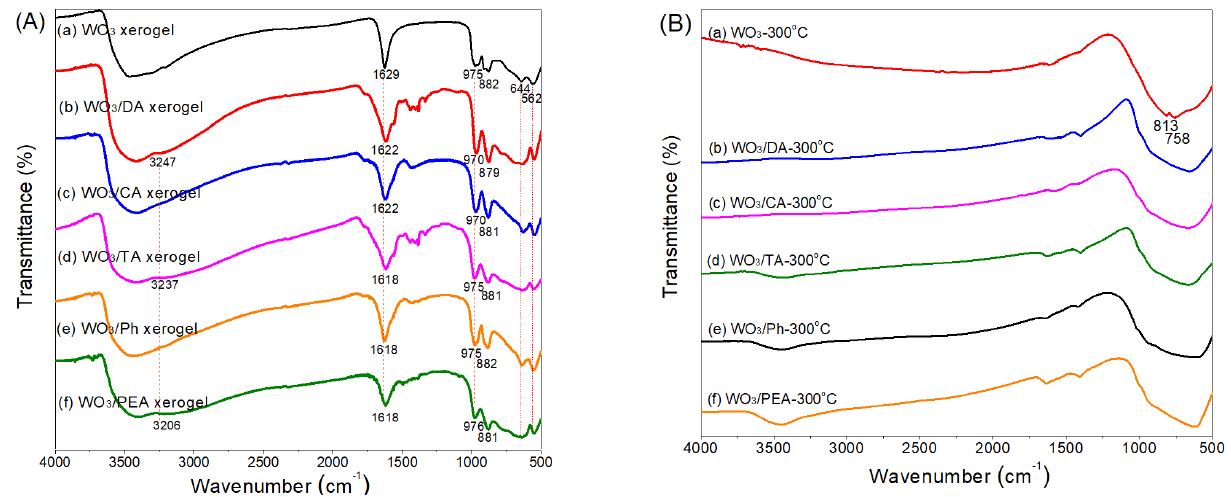
Figure 3. ( A ) FTIR spectra of (a) WO 3 , (b) WO 3 /DA, (c) WO 3 /CA, (d) WO 3 /TA, (e) WO 3 /Ph and (f) WO 3 /PEA xerogels, and ( B ) FTIR spectra of (a) WO 3 -300 °C, (b) WO 3 /DA-300 °C, (c) WO 3 /CA-300 °C, (d) WO 3 /TA-300 °C, (e) WO 3 /Ph-300 °C and (f) WO 3 /PEA-300 °C fi lms.